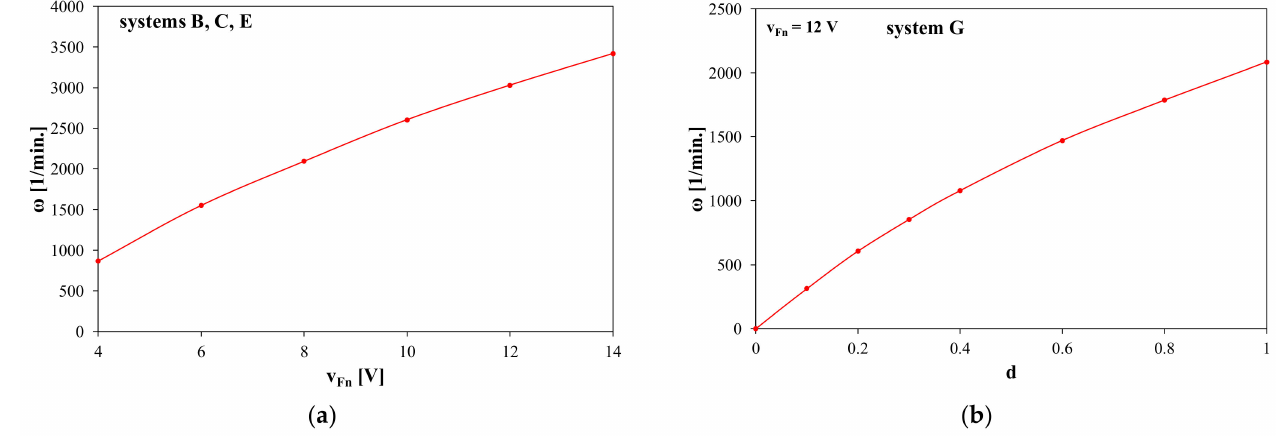
Figure 11. Dependences of the rotational speed of the fan ( a ) used in cooling systems B, C and E on its supply voltage and ( b ) the fan used in system G on the duty factor of its PWM supply signal.